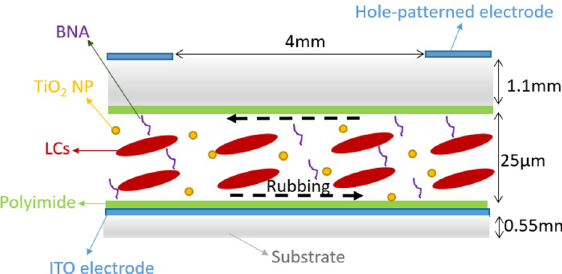
Figure 1. Diagram of the BR composite-doped HLC lens